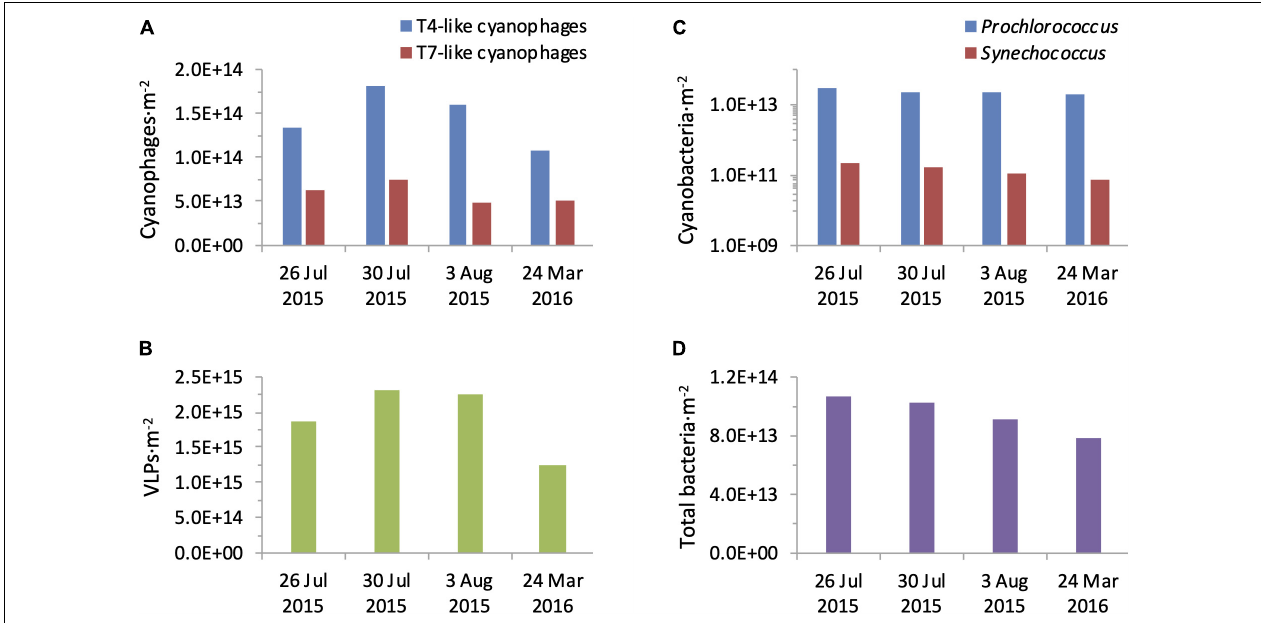
FIGURE 7 | Integrated water column abundances of bacteria and viruses. Abundances of T4-like and T7-like cyanophages (A) , VLPs (B) , Prochlorococcus and Synechococcus (C) , and total bacteria (D) were calculated for a 1 m 2 water column of 150 m depth from each profile collected during the summer 2015 and spring 2016